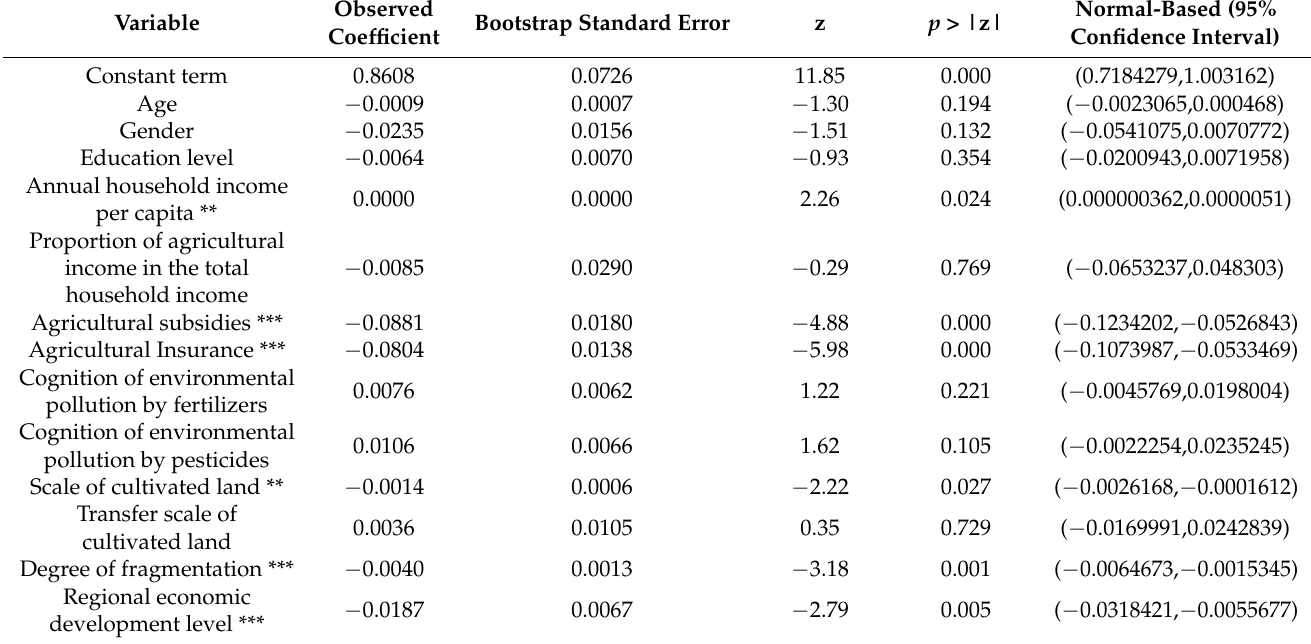
Table 4. Tobit regression results of influencing factors of farming households’ GUECL (n =